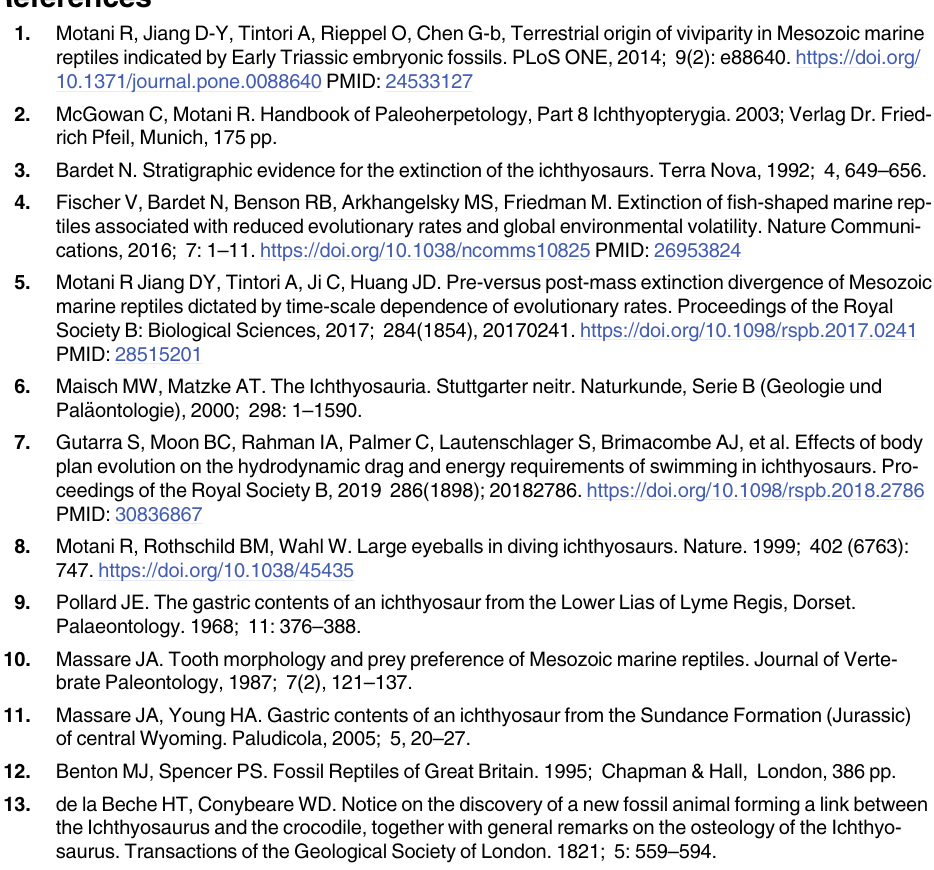
S5 Table. Selected pelvic girdle measurements (in